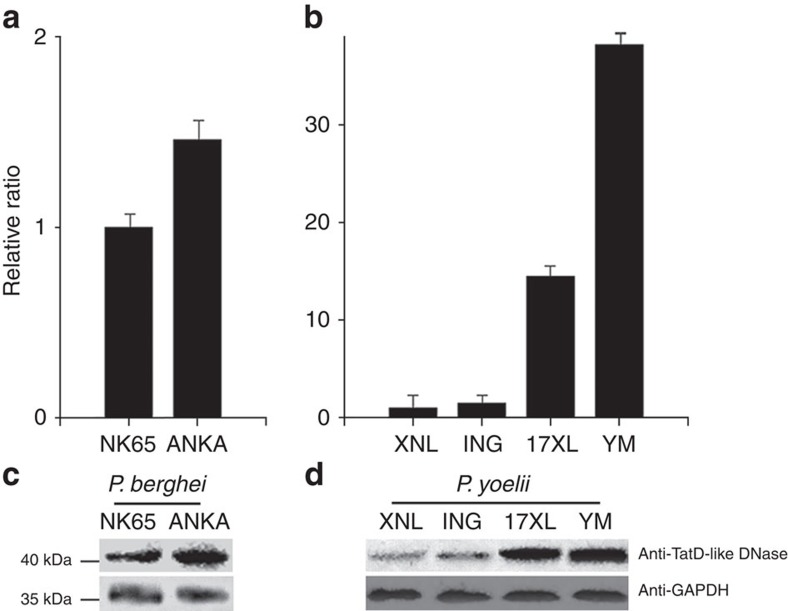
TatD-like DNase expression is associated with parasite virulence.Quantitative PCR and western blot assays were performed to measure mRNA and protein levels, respectively, of the TatD-like DNase in rodent malarial parasites. In the histograms presented in a,b parasite pathogenicity increased from the left to right, which positively correlated with transcription. Error bars represent the mean ±s.e.m. of three independent experiments. The expression patterns presented in c,d also positively correlated with the transcription results. The top panel indicates the TatD expression in different strains, which were collected at the same stage of the parasites. GAPDH is presented in the bottom panel and was used as a control. The full images of the western blot assays are shown in Supplementary Fig. 13.